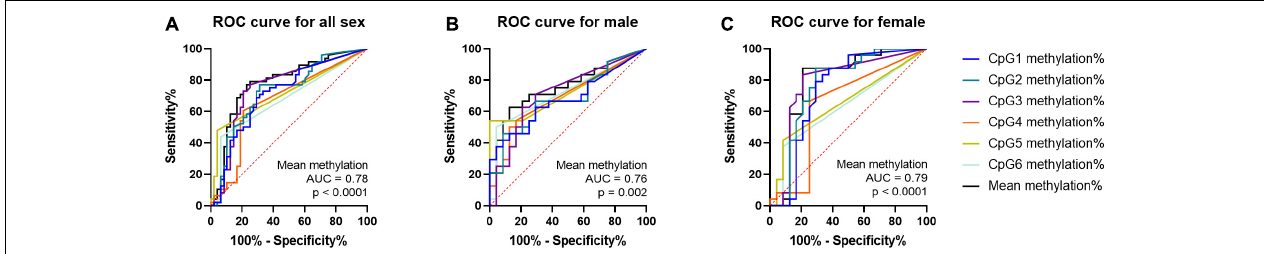
FIGURE 4 | ROC curves of PTBP1 DNA methylation in all sexes, male and female samples. (A) ROC curve for PTBP1 DNA methylation in all sexes. (B) ROC curve for PTBP1 DNA methylation in males. (C) ROC curve for PTBP1 DNA methylation in females.